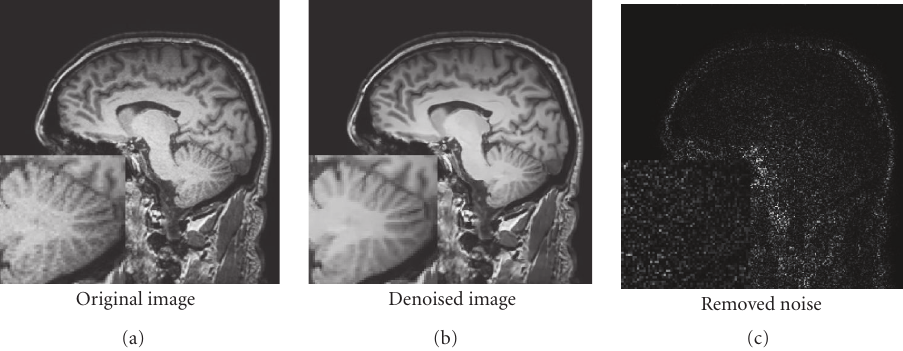
Figure 11: Fully automatic restoration obtained with the optimized blockwise NL-means with wavelet mixing filter on a 3 Tesla T1-w MRI data of 256 3 voxels in less than 4 minutes on a DualCore Intel(R) Pentium(R) D CPU 3.40